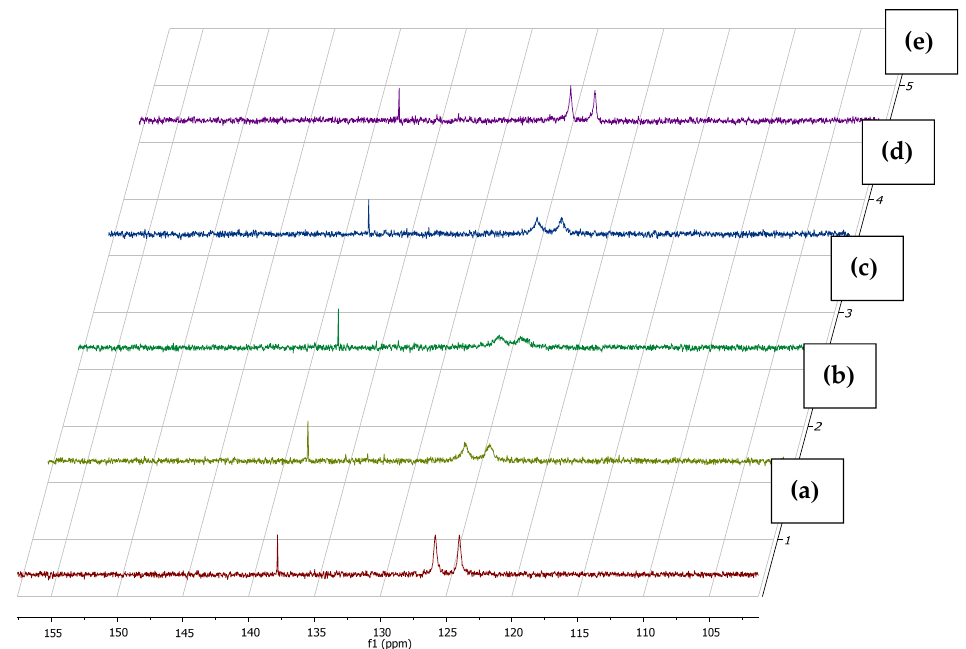
Figure 3. 31 P NMR spectra of L2 + Rh(CO) 2 (acac) (molar ratio = 1:1), in toluene-d8, at different tem- peratures: ( a ) − 3 °C; ( b ) 10 °C; ( c ) 25 °C; ( d ) 50 °C; ( e ) 80 °C (expansion of the region 105–155 ppm).